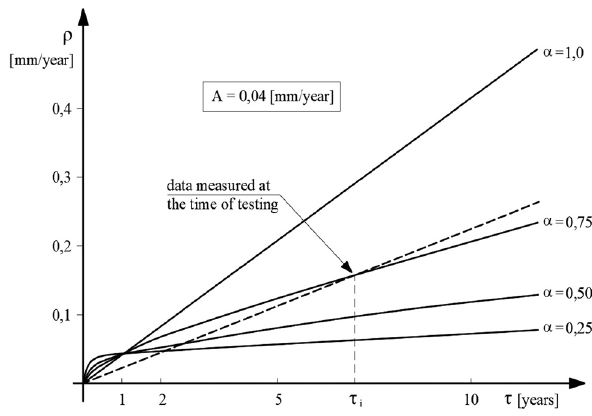
Figure 1: Increase of the sheet thickness corrosion loss described by the equation ( 2 ) assuming that A = 0.04 ( mm/year )